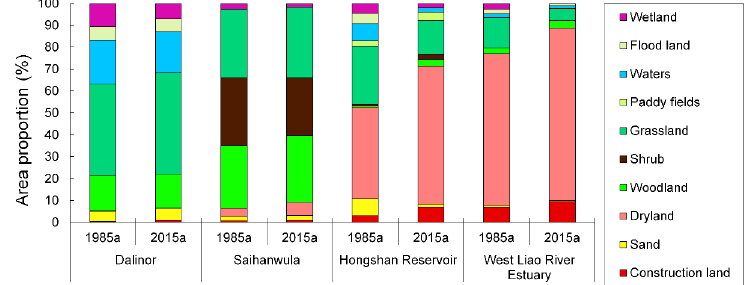
Figure 6. Changes in the proportion of land use in each study